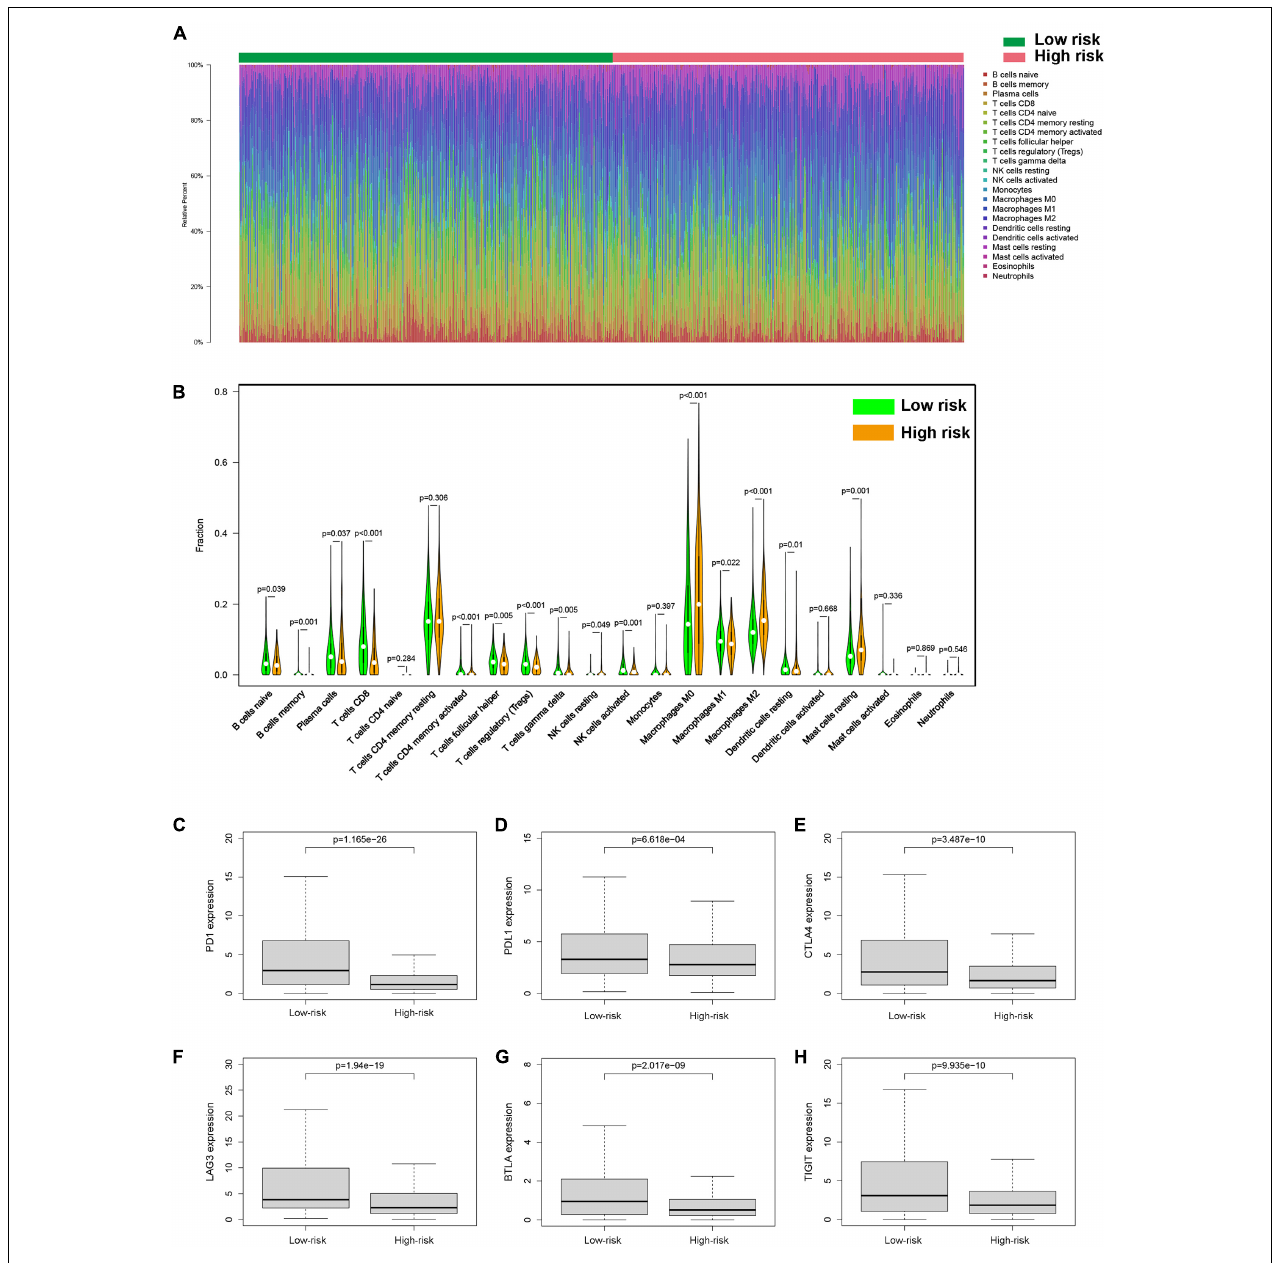
FIGURE 8 | Tumor-infiltrating immune cells of BC patients. (A) The proportions of different tumor-infiltrating immune cells in the low-risk and high-risk groups. (B) Violin plot showed the different proportions of tumor-infiltrating cells between the high-risk group and low-risk group. The expression levels of PD1 (C) , PDL1 (D) , CTLA4 (E) , LAG3 (F) , BTLA (G) , and TIGIT (H) in the high-risk group and low-risk